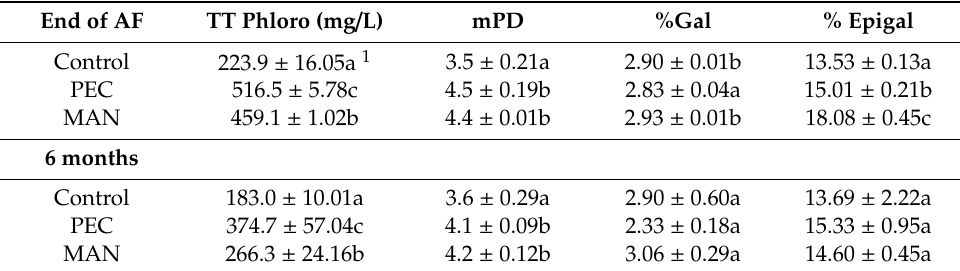
Table 7. Concentration and composition of the tannins of wines treated with commercial soluble polysaccharides analyzed by the phloroglucinolysis method.